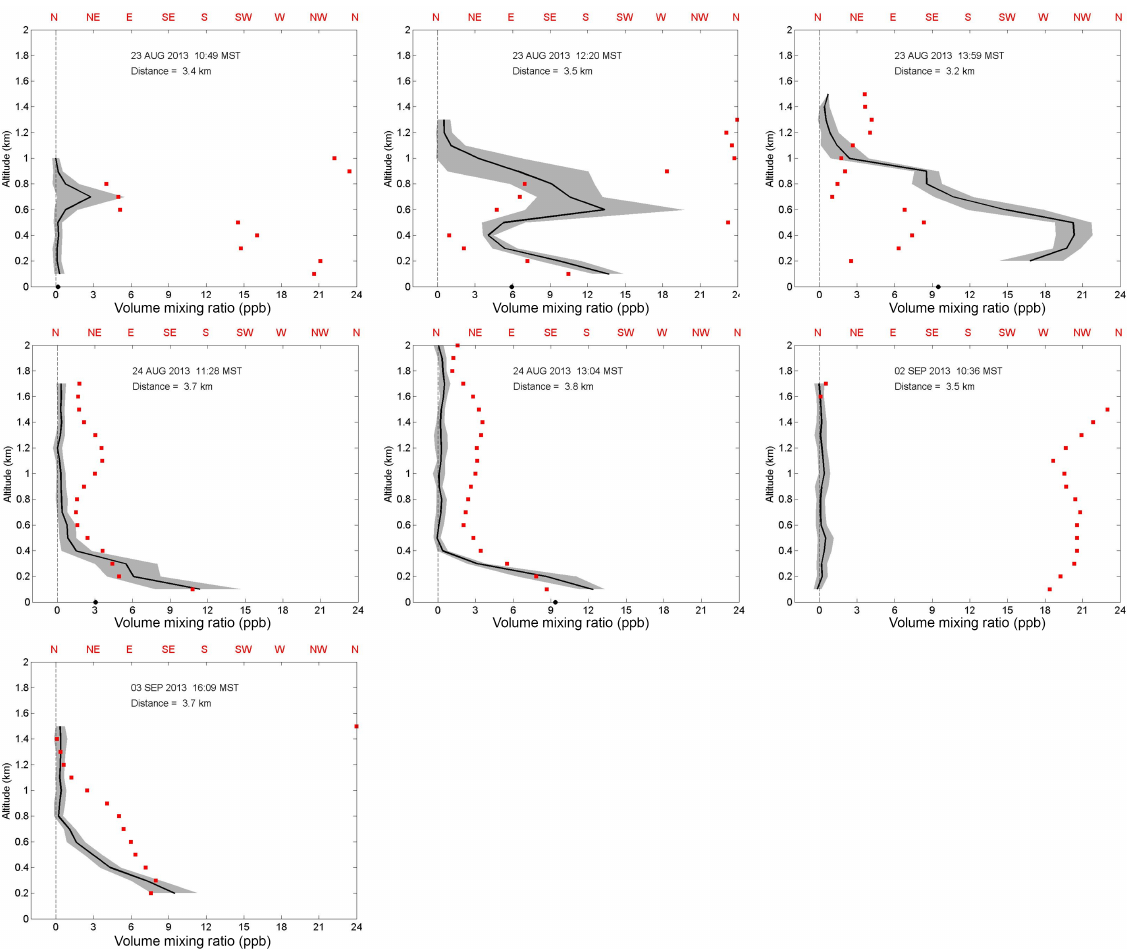
Figure 10. The measured vertical profiles of SO 2 mixing ratios in ppbv (the black lines) with 1 σ uncertainties as a function of altitude for seven spiral flights around Fort McKay in August–September 2013. The black dots indicate mixing ratios at the surface. The red dots represent the wind directions as labelled on the top axis. Note that the two major SO 2 sources are located to the south and south–south east of Fort McKay. The dates and times of the flights and the mean distances from Fort McKay are also